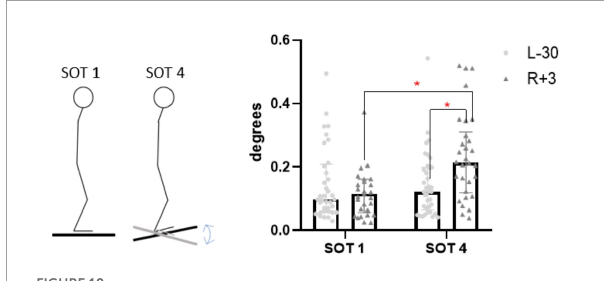
the contribution of vestibular system (i.e., SOT1-SOT5), revealed recovery of postural control to the baseline values by R +